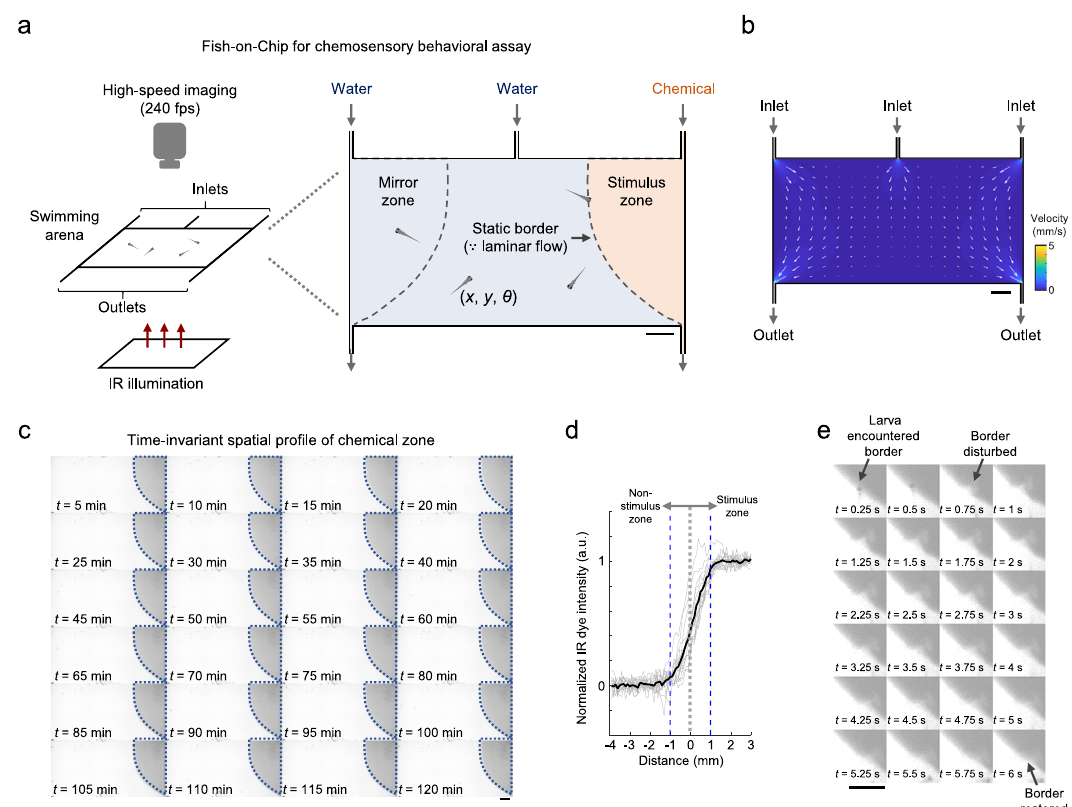
Fig. 1 | A fl uidics-based swimming arena for chemosensory behavioral assay. a Schematics of the chemosensorybehavioral assay. Zebra fi shlarvaeswimming in a two-dimensional arena (60mm×30mm×1.5mm) are imaged at high speed (240fps)underinfrared(IR)illuminationintheabsenceofvisiblelight.Achemical zone(stimuluszone)iscreatedandmaintainedbyaconstantslowin fl owofagiven chemical(dissolvedinwater)viatherightmost fl uidinlet.Assaysinwhichallzones are fi lledbywaterstreamsserveascontrol.Thesymmetricalmirrorzoneservesas anadditional control for obtaining baseline behaviors when infusedby water. The laminar fl ow maintains a static border between the zones. The coordinates ( x , y ) and orientation ( θ ) of the center of the head are tracked and analyzed for each larval zebra fi sh. b Simulated fl uid velocity pro fi le in the swimming arena. Vectors showthedirectionof fl owattherespectivelocations,withlengthscalingaccording to the relative magnitude of velocity. The absolute magnitude of velocity is color-